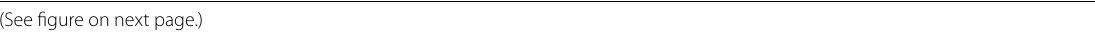
figure on next Figure 7 Investigation of thermal effects after laser machining: ( a ) the thermal penetration depth is plotted relative to the radial distance from the laser beam centre measured by infrared thermography. The profiles were selected from the recorded frame where the radial distance from the beam centre at a temperature greater than 50 °C was at a maximum. A 50 °C reference line is also plotted. ( b ) The cooling behaviour was studied through the use of temporal plots evaluating the maximum temperature along a radial profile from the beam centre relative to the time passed since peak temperature was